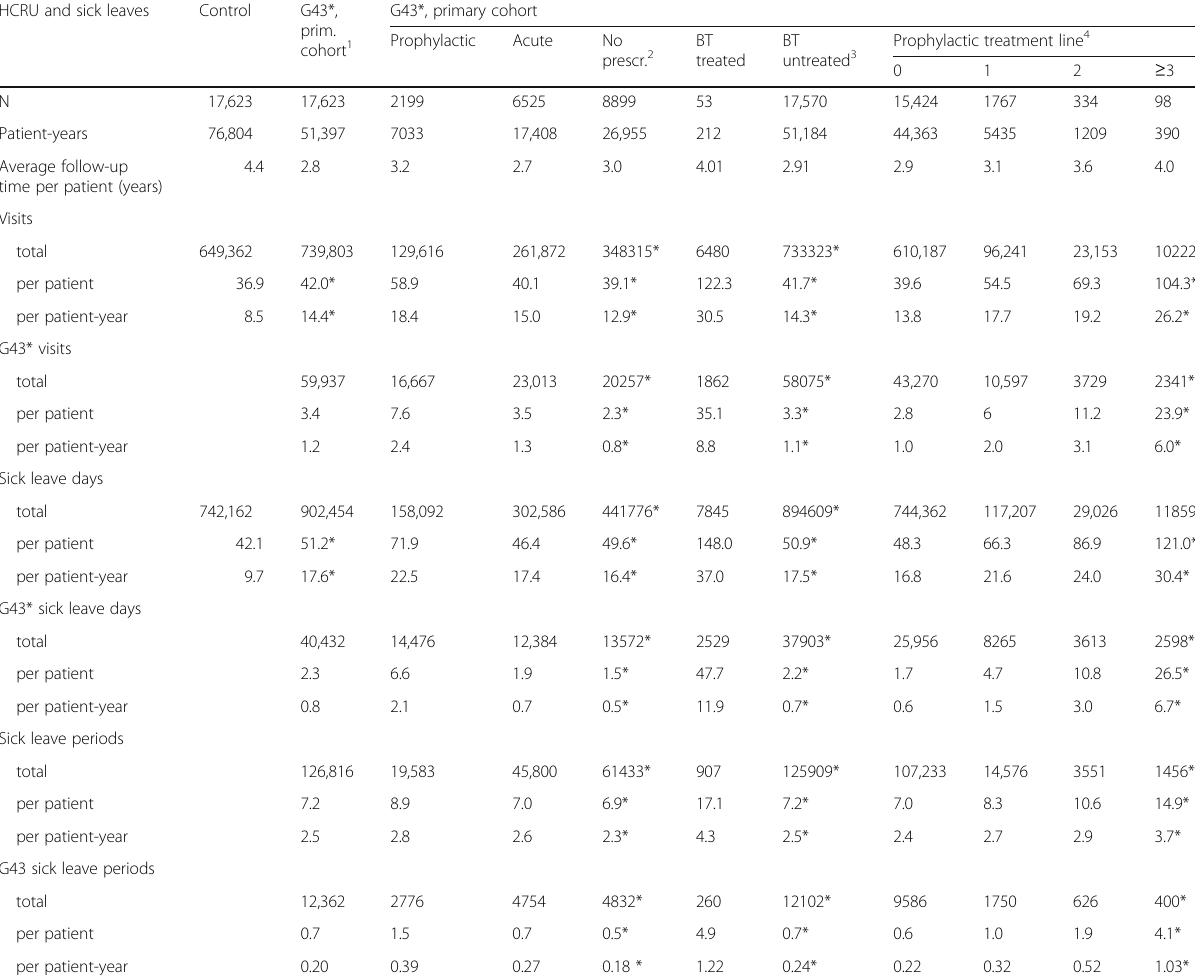
Table 2 Total and disease specific visits and sick-leave days of migraine patients and controls HCRU and sick leaves Control G43*,